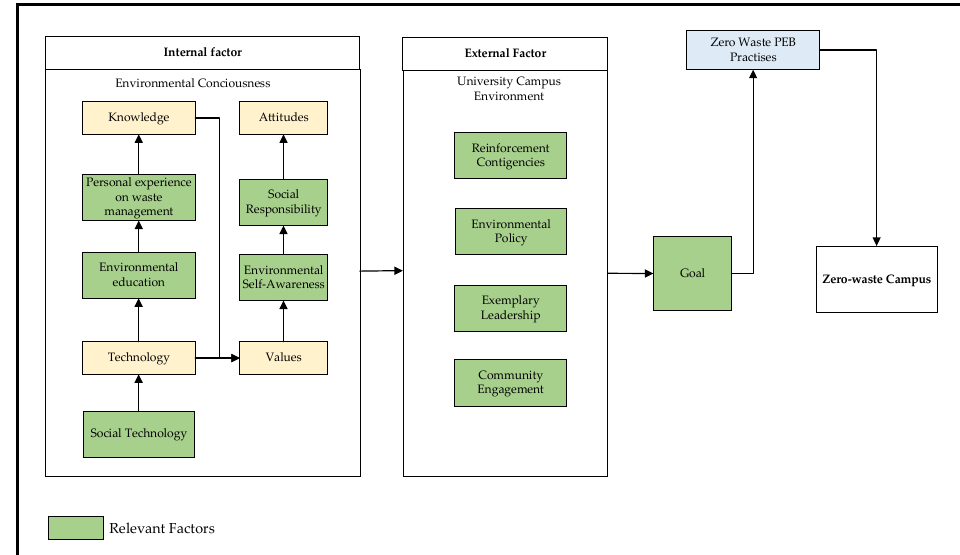
Figure 2. Zero-Waste Campus